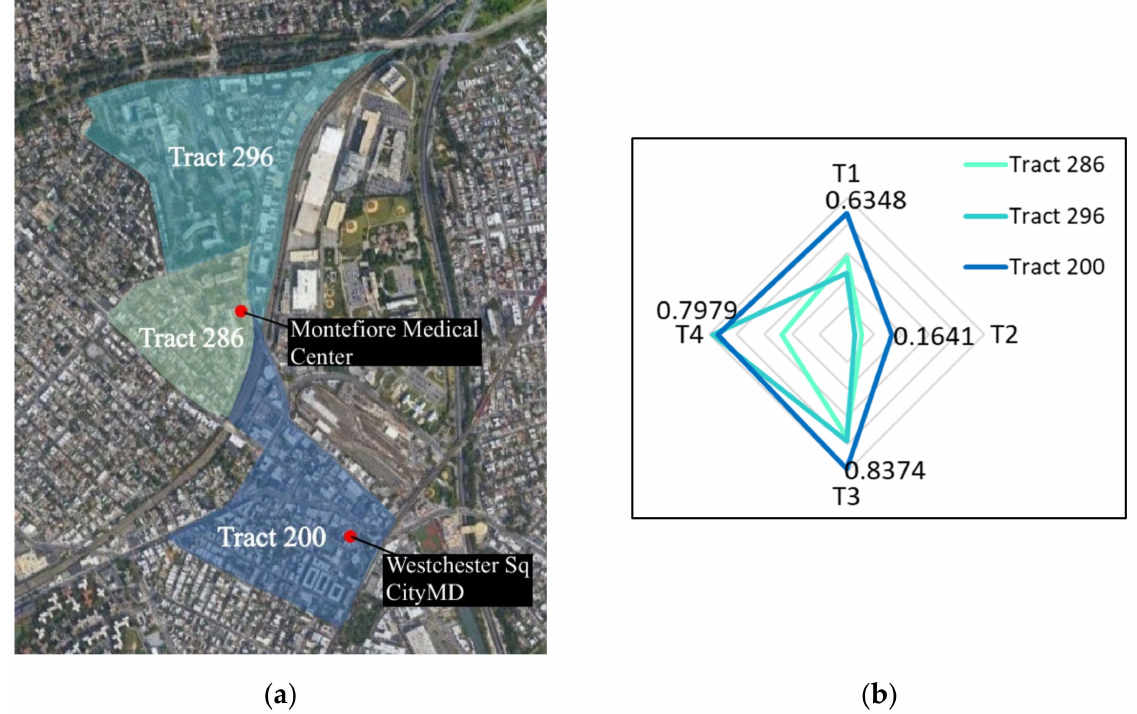
Figure 3. Community characteristics around Montefiore Medical Center: ( a ) satellite image overlain by tract boundaries and their population for tri-partite population areas surrounding Montefiore Medical Center; ( b ) visualized weighted SVI for areas in 3a, where T1 is socioeconomic status, T2 is household composition and disability, T3 is minority status and language, and T4 is housing type and